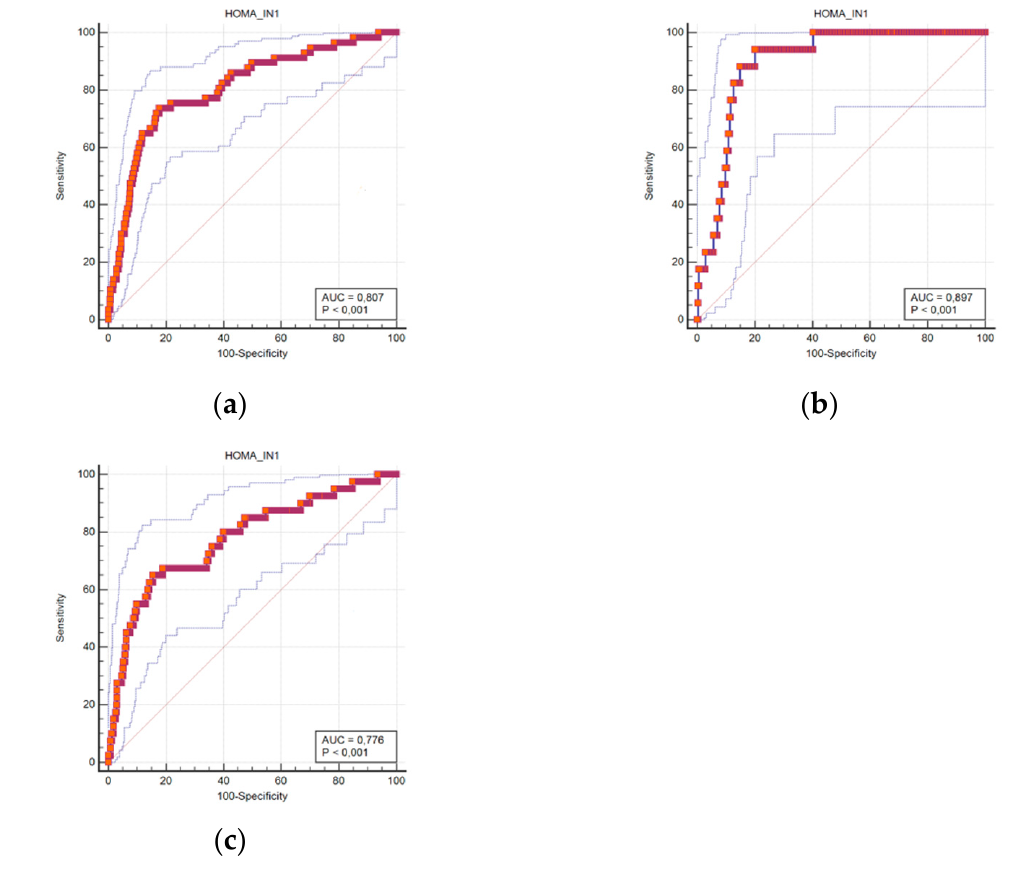
Figure 1. Receiver operating characteristic curves for DM prediction using the HOMA-IR score cut-offs in all subjects ( a ), men ( b ), and women ( c ).